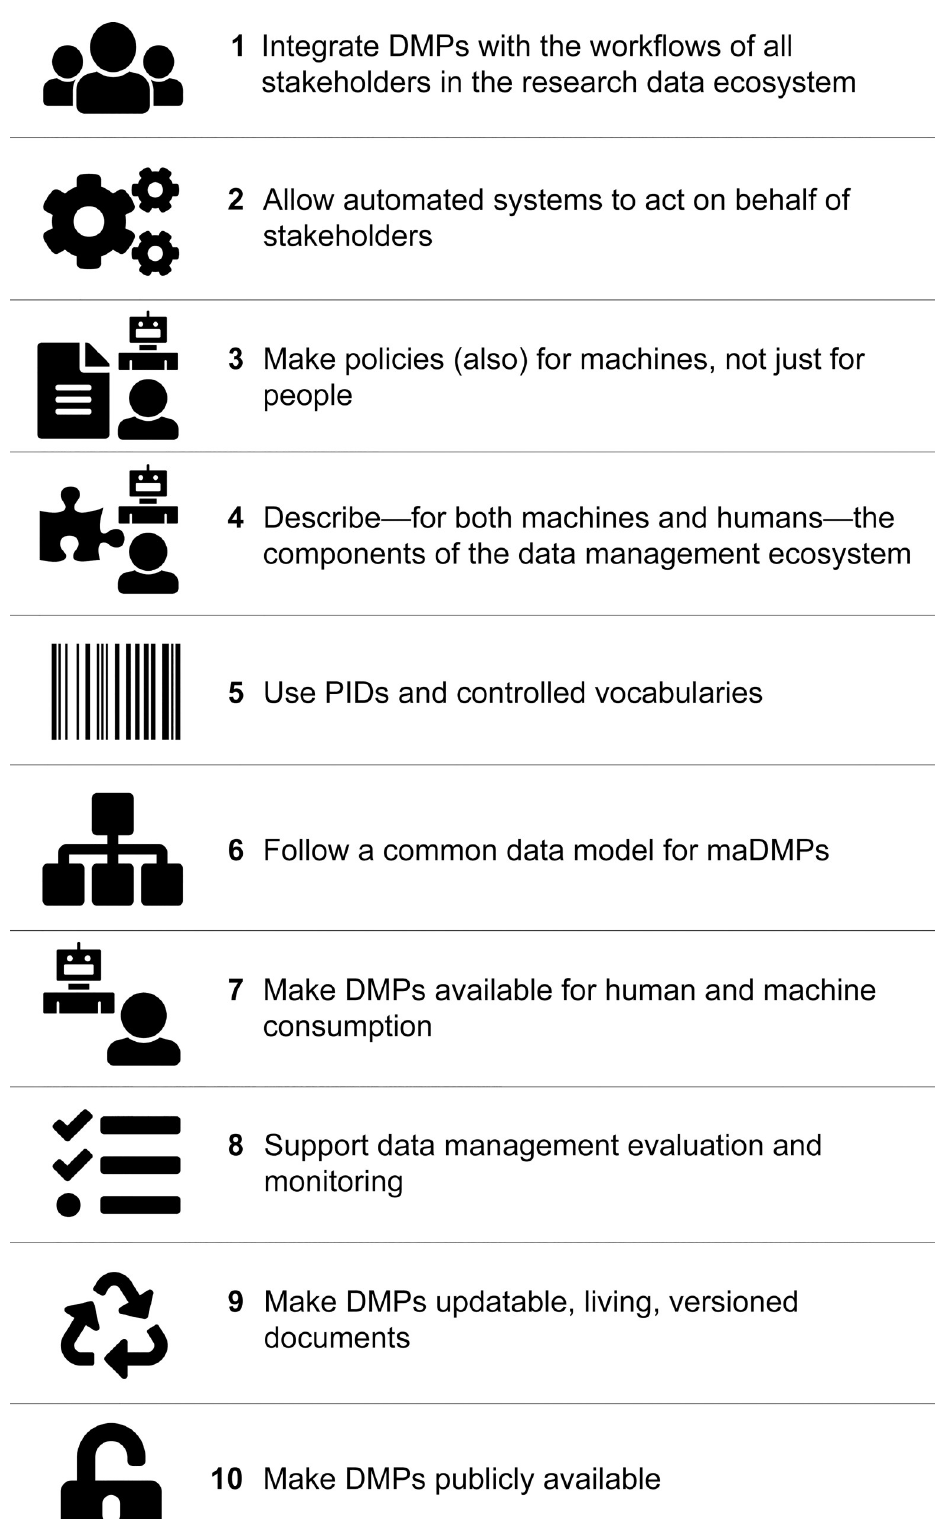
Fig 2. Ten principles for maDMPs at a glance. DMP, data management plan; maDMP, machine-actionable data management plan; PID, persistent identifier.